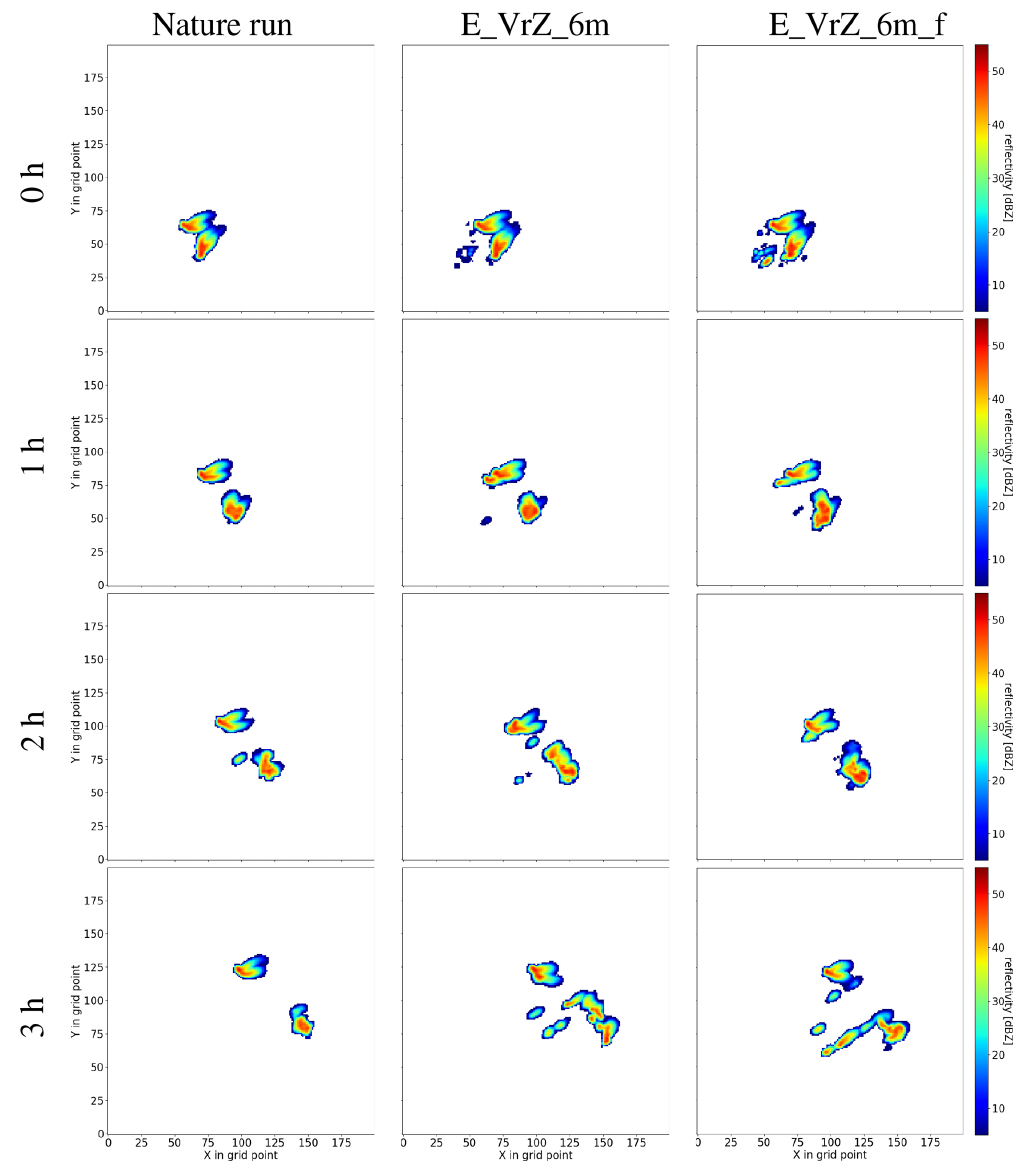
Figure 9. Deterministic forecasts (starting at 15:00UTC) of E_VrZ_6m (middle) and E_VrZ_6m_f (right) based on the reflectivity composite at the elevation 0 . 5 ◦ . The forecasts at the initial times of 1, 2 and 3h are presented from top to bottom. The left column is the nature